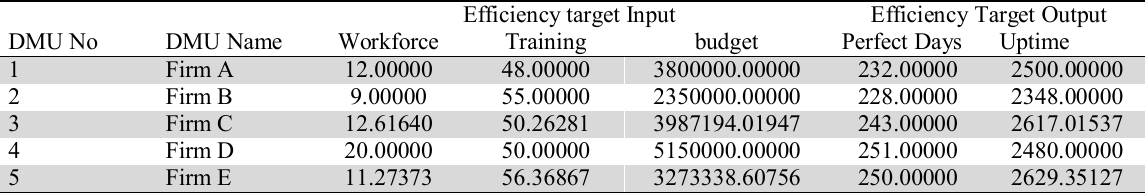
Input and output efficient targets for construction firm